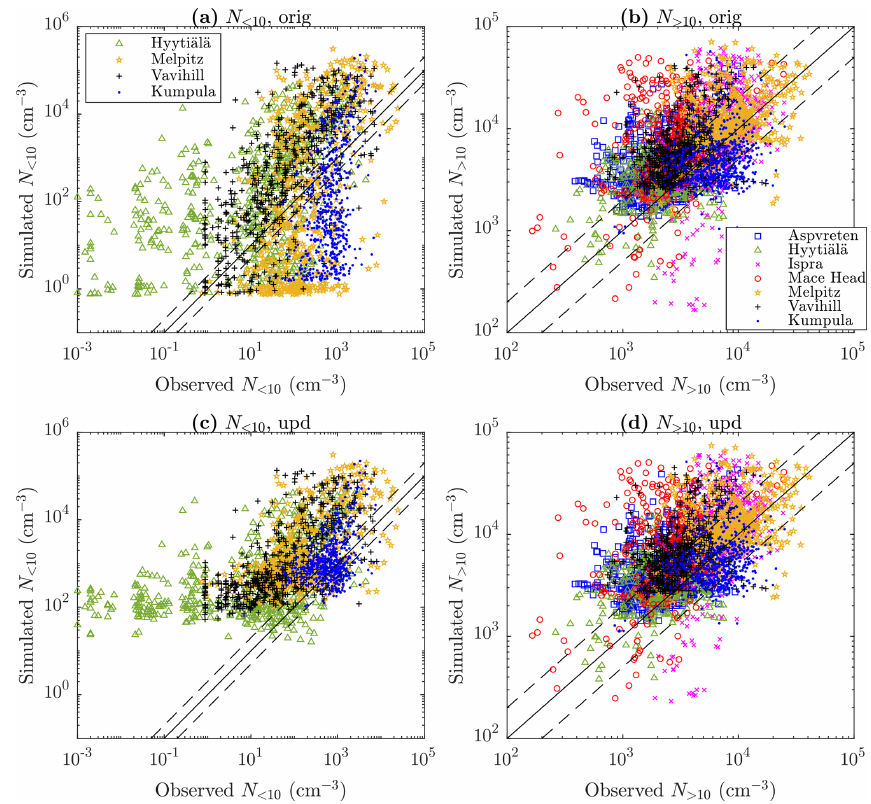
Figure 3. Simulated versus observed number concentrations of particles (a, c) smaller than 10nm ( N < 10 ) and (b, d) larger than 10nm ( N > 10 ) at selected measurement stations with (a, b) the original and (c, d) updated emission inventory. All data correspond to hourly means for May 2008. The solid diagonal lines represent 1 : 1 lines and the dashed ones 1 : 2 and 2 : 1 lines. See Fig. S6 for a clearer presentation of the data from the stations with the highest traffic influences only (Melpitz and Kumpula).